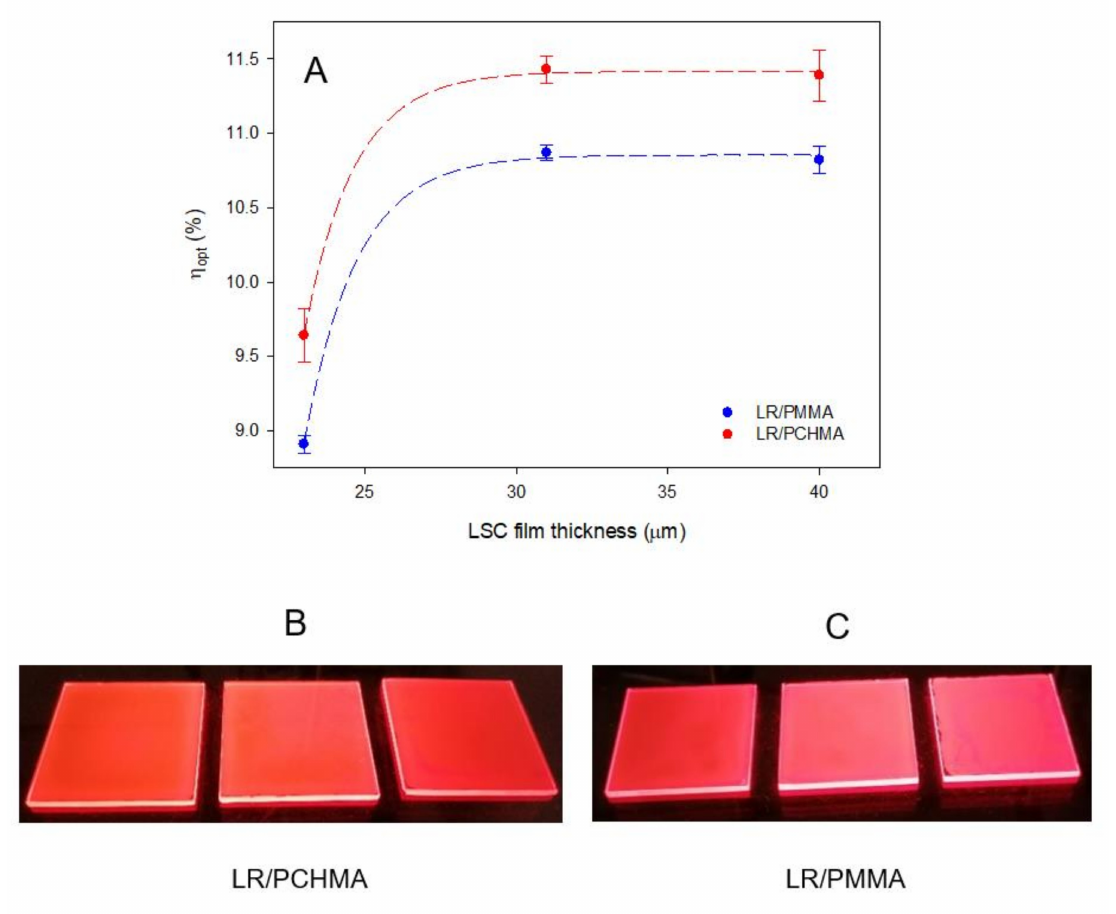
Figure 8. ( A ) η opt of LSC systems versus LSC film thickness at 1.00 wt% of LR for both polymeric matrices investigated and ( B , C ) pictures of the same LR / polymer LSC (50 mm × 50 mm × 3 mm) under the excitation with a Dark Reader 46B transilluminator ( ∼ 450 nm) with increasing film thickness (from left to right). Error bars represent standard deviation in each η opt value ( n =